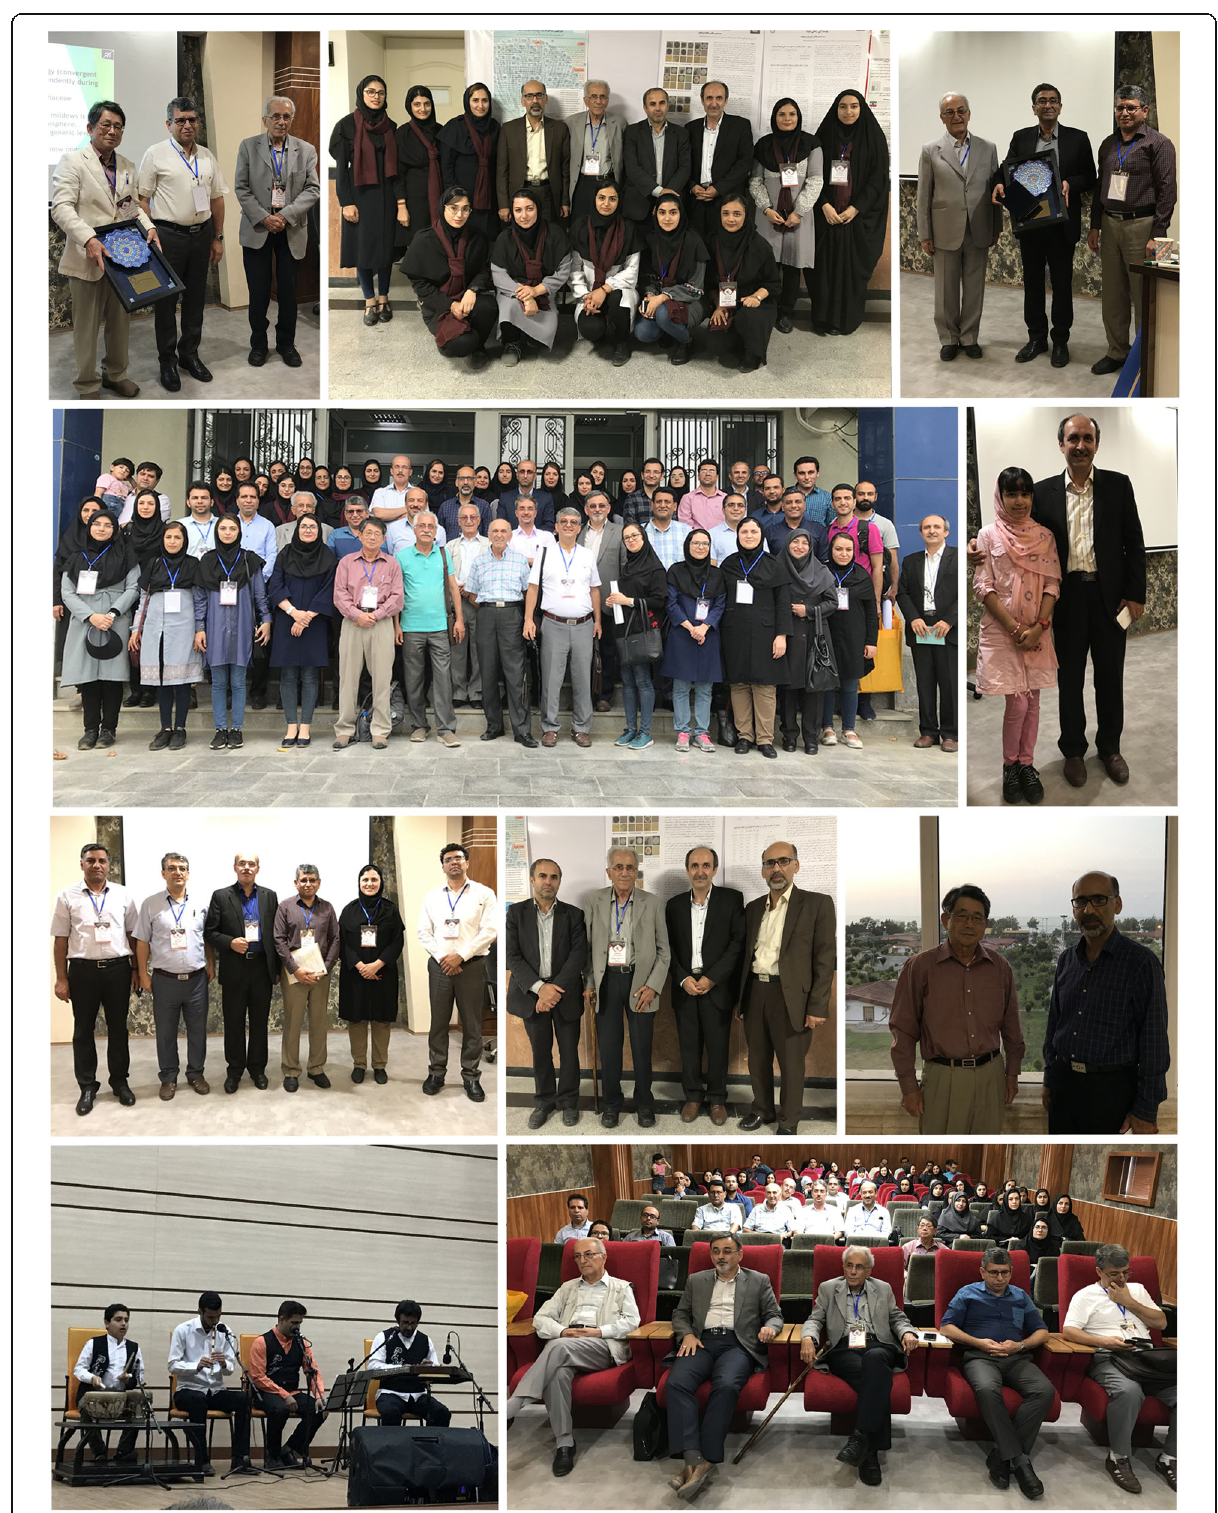
Fig. 5 Scenes from 4th Iranian Mycological